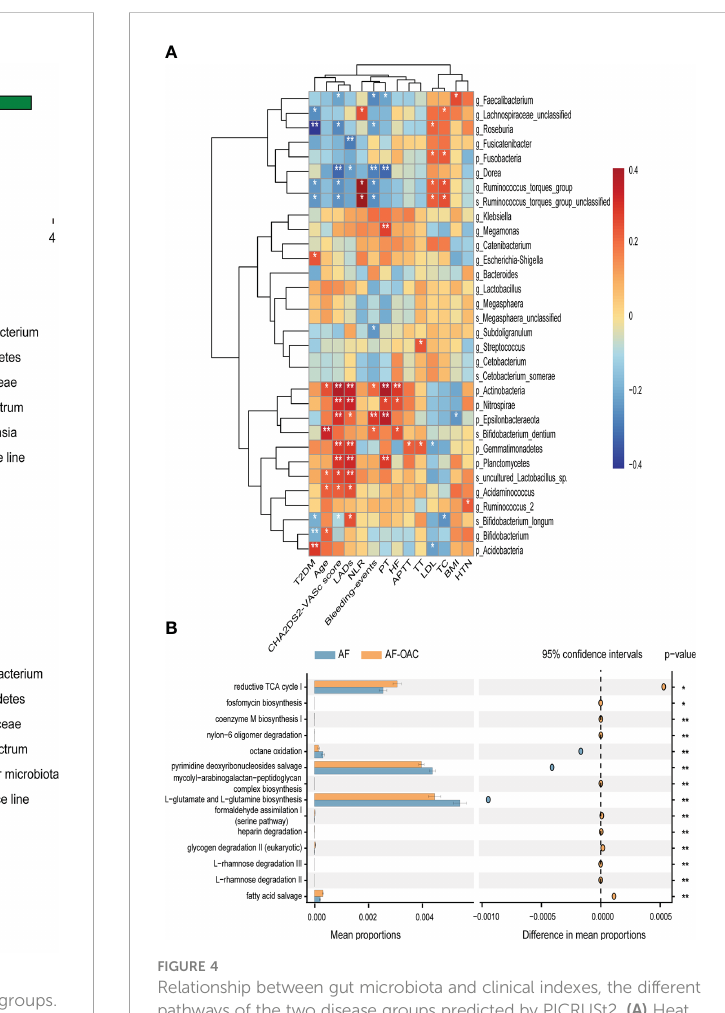
FIGURE 3 Difference taxa between the bleeding and non-bleeding subgroups. (A) LEfSe analysis of gut microbiota between the two subgroups. (B) These fi ve taxa were selected based on LEfSe analysis and the best predictive taxa with the highest AUC [ Bacteroidetes (AUC = 0.72, 95% CI (0.56 – 0.88), P < 0.05] and Faecalibacterium [AUC 0.76, 95% CI (0.49 – 0.85), P < 0.05)). (C) Joint ROC cure [AUC = 0.88, 95% CI (0.78 – 0.98), P < 0.05